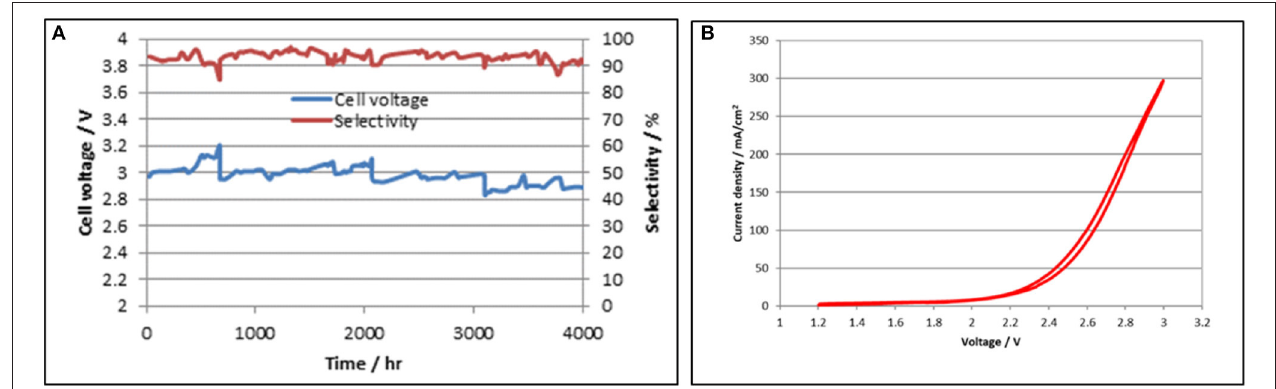
FIGURE 7 | 5.0 cm 2 long term cell test data showing stable performance for 4,000h is shown on the left in (A) . A cell voltage polarization plot for the 5.0 cm 2 CO 2 cell operating at room temperature is shown on the right in (B) .